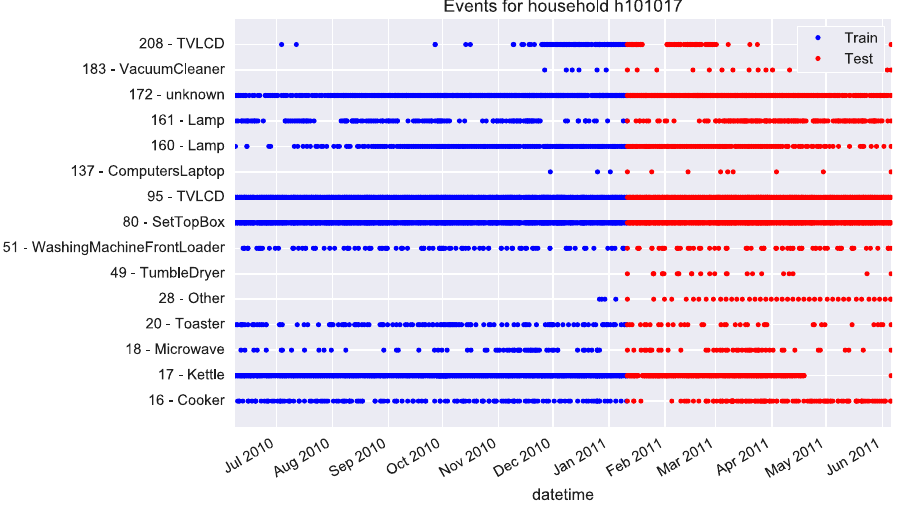
Figure 2. Training and test event samples for household No. 101017 in HES dataset.